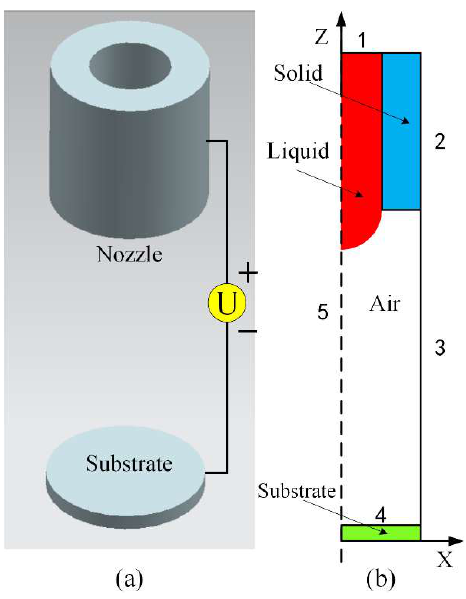
Figure 2. ( a ) Schematic diagram of nozzle-substrate structure, ( b ) schematic diagram of the three-phase calculation model in simulation.